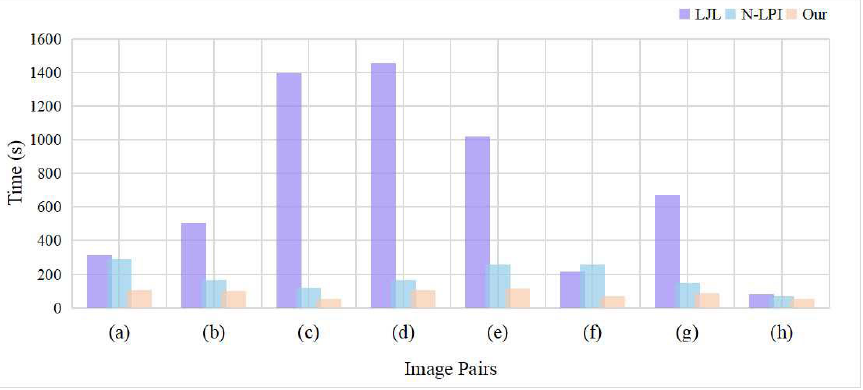
Figure 13. Running time of the three approaches for 8 image pairs. ( a – h ) are Figure 7a–h image pairs.